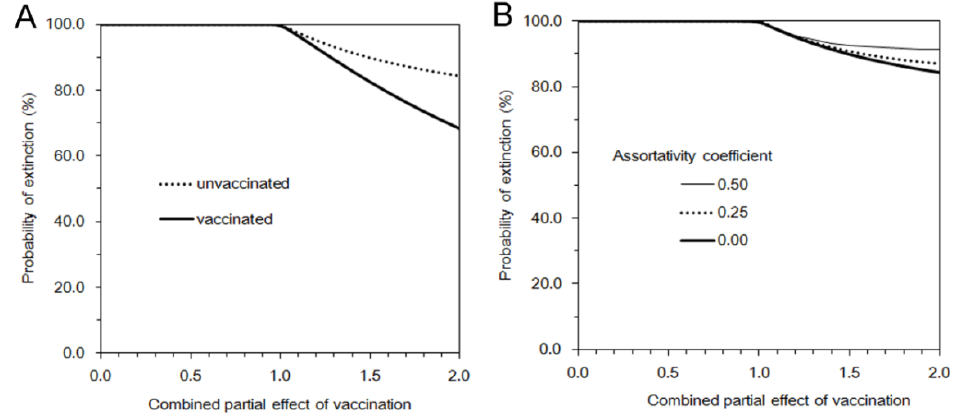
α α α that measures the partial effects of vaccination. s i m d